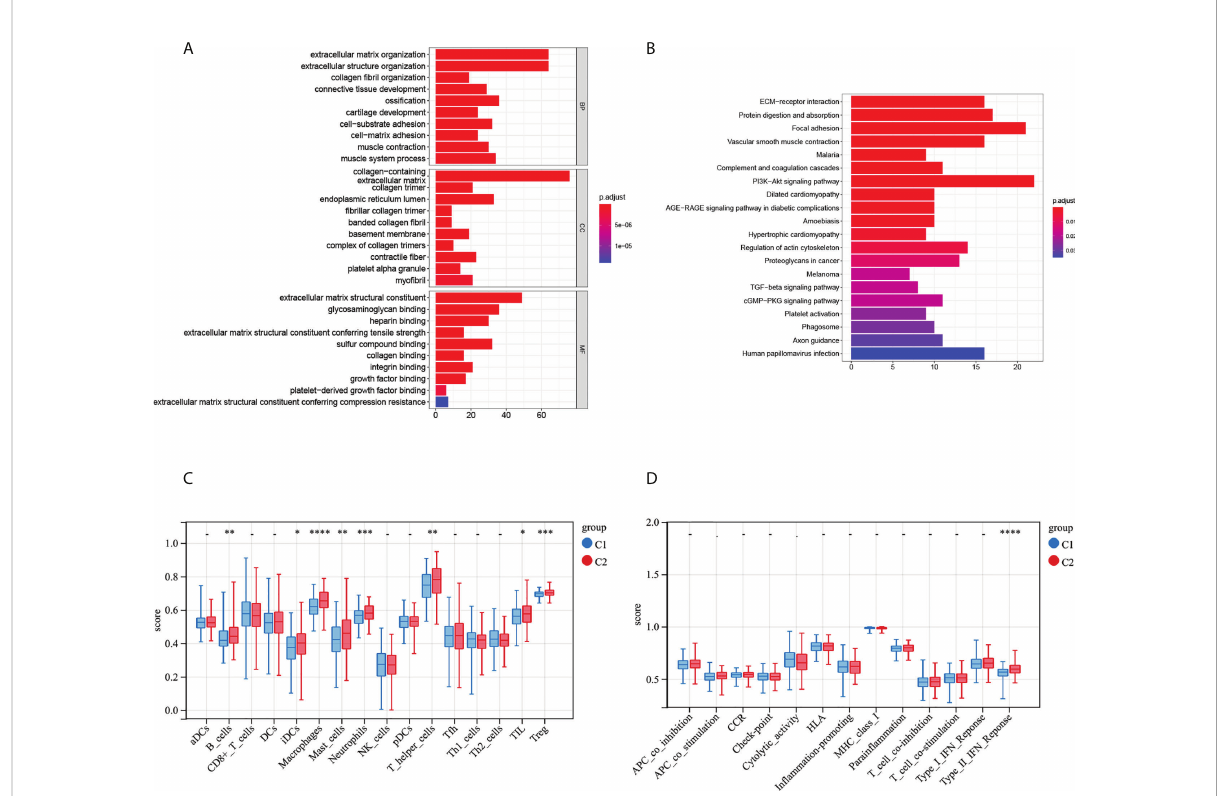
FIGURE 5 Differential immune characteristics of MMRG patterns C1 and C2. (A) GO bar graph for genes in BP, CC, and MF. (B) Bubble graph of the top fi ve KEGG pathways with the most enriched genes; the vertical axis refers to the names of the pathway, and the horizontal axis refers to the number of genes. (C) Relative in fi ltration of 16 types of immune cells in MMRG clusters C1 and C2. (D) Relative enrichment score of 13 immune-related functions in MMRG clusters C1 and C2. GO, Gene Ontology; BP, biological process; CC, cellular component; MF, molecular function; KEGG, Kyoto Encyclopedia of Genes and Genomes. *p < 0.05; **p < 0.01; ***p < 0.001; ****p <